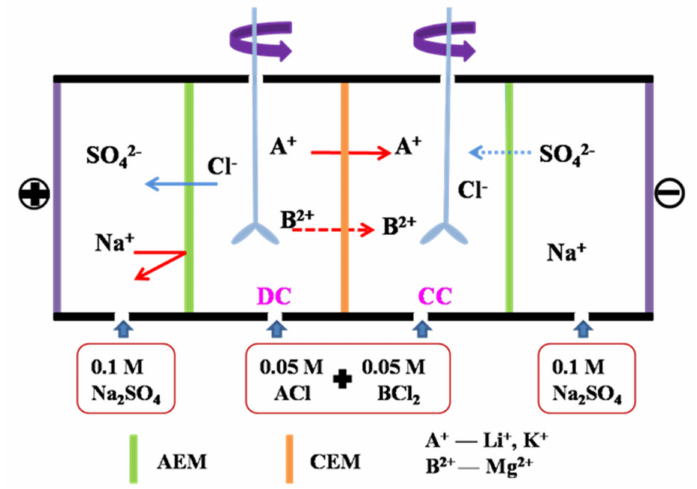
Figure 3. Schematic ED apparatus for the measurement of cation permselectivity for the pristine and modified